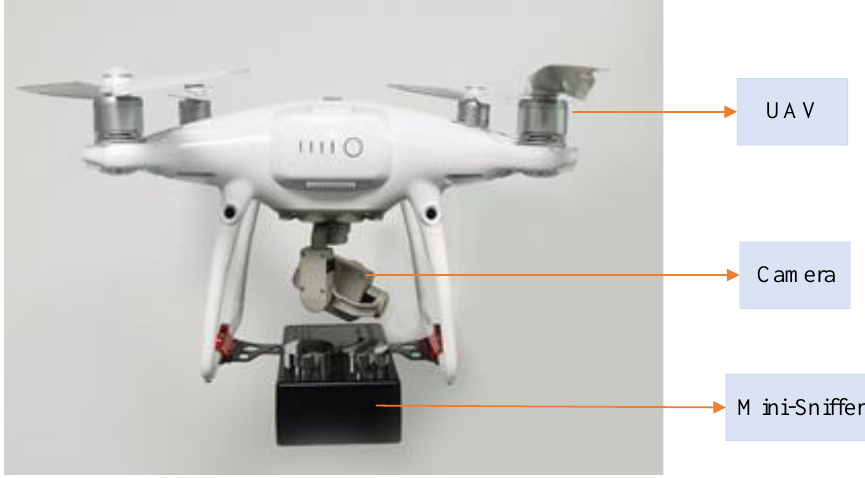
Figure 2. Image of ship exhaust mini-sniffing UAV system.